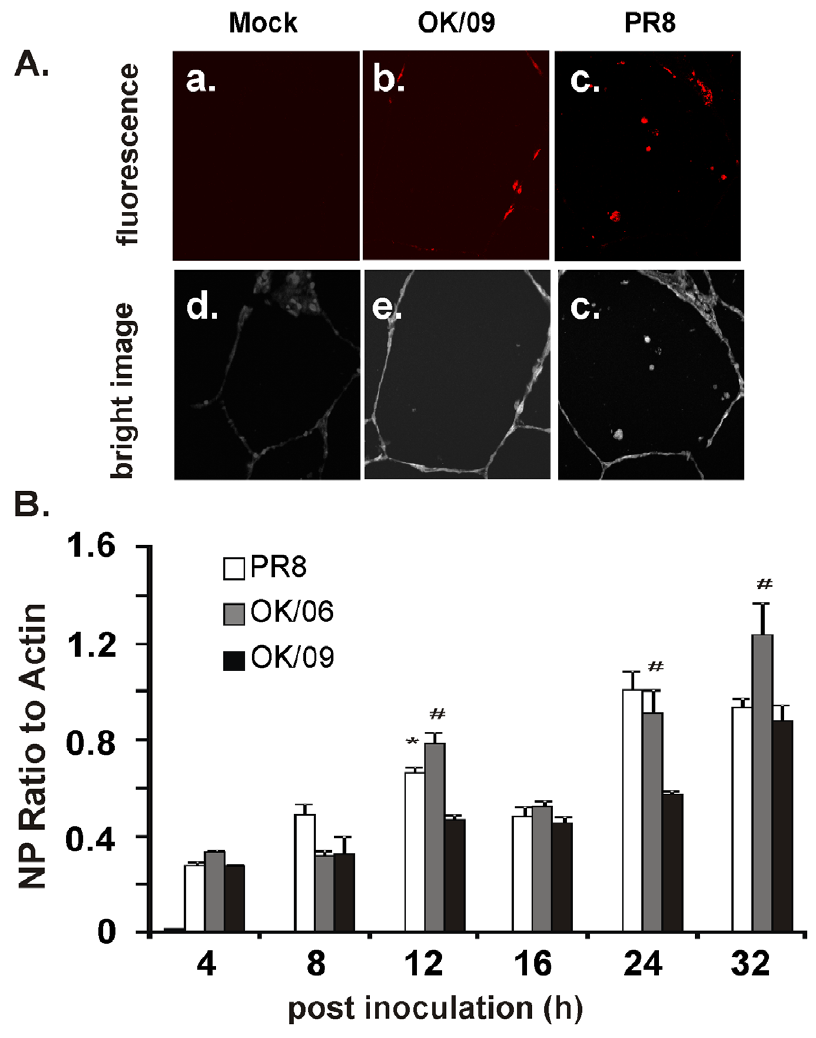
Figure 1. Exposure of human lung to both pandemic and prototypic influenza virus results in viral infection and replication in alveolar cells. (A) The lung slices were processed for immunohistochemistry for detection of viral NP using rabbit polyclonal antibody (red). Panels a, b and c show mock (virus dilution buffer), OK/09 and PR8 infection, respectively. Panels d, e and f are corresponding bright-field images that demonstrate that lung architecture is preserved during the experiment. (B) Replication of influenza virus OK/09, OK/06 and PR8 in the human lung organ culture model. Lung slices exposed to virus at 6 6 10 6 PFU/ml were cultured for various times and total cellular mRNA was extracted. Quantitative RT-PCR was performed using Oligo dT as the primer for the first strand synthesis. Primers specific for NP were used to examine NP mRNA expression.